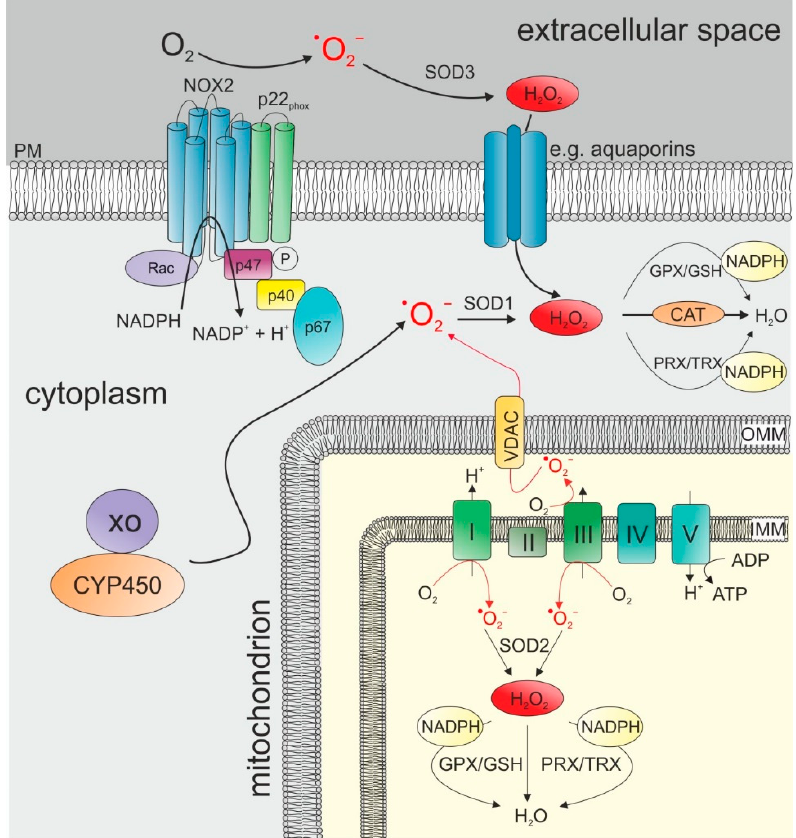
Figure 3. The main sources of ROS production and elimination: ROS can be generated either by activated NADPH oxidases (here represented by NOX2) located in the plasma membrane or by several complexes of the electron transport chain in the inner membrane of mitochondria. Other metabolic enzymes include xanthine oxidase (XO) and cytochrome P450 (CYP450) that directly form superoxide in the cytoplasm. Superoxide dismutases (SODs) can convert • O 2 ¯ to H 2 O 2 . SOD1 is located in the cytoplasm, SOD2 is located in the mitochondrial matrix, and SOD3 is located in the extracellular space. The further elimination of H 2 O 2 via catalase, GPX/GSH, and/or PRX/TRX can either be initiated directly in the mitochondrial matrix or in the cytoplasm upon the transport of H 2 O 2 via aquaporins. CYP450: cytochrome P450; IMM: inner mitochondrial membrane; OMM: outer mitochrondrial membrane; PM: plasma membrane; VDAC: voltage-dependent anion channel; XO: xanthine oxidase.